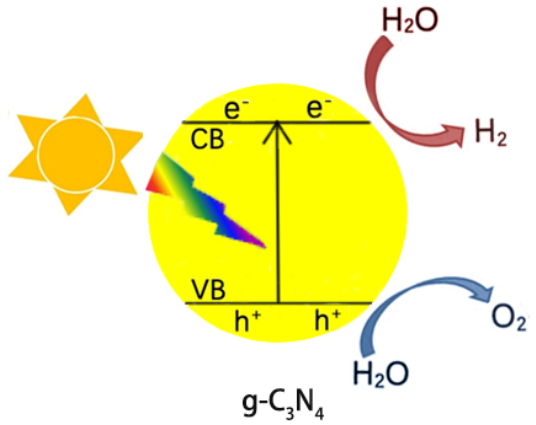
Figure 15. Scheme of photocatalytic water splitting into H 2 and O 2 over g − C 3 N 4 under light irradi-